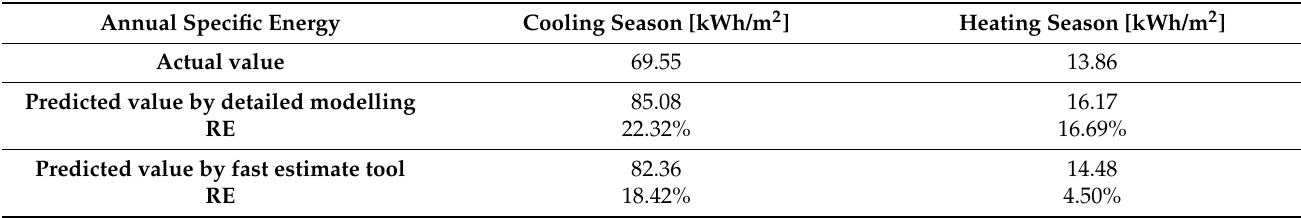
Table 9. Comparison between predicted and actual annual cooling/heating